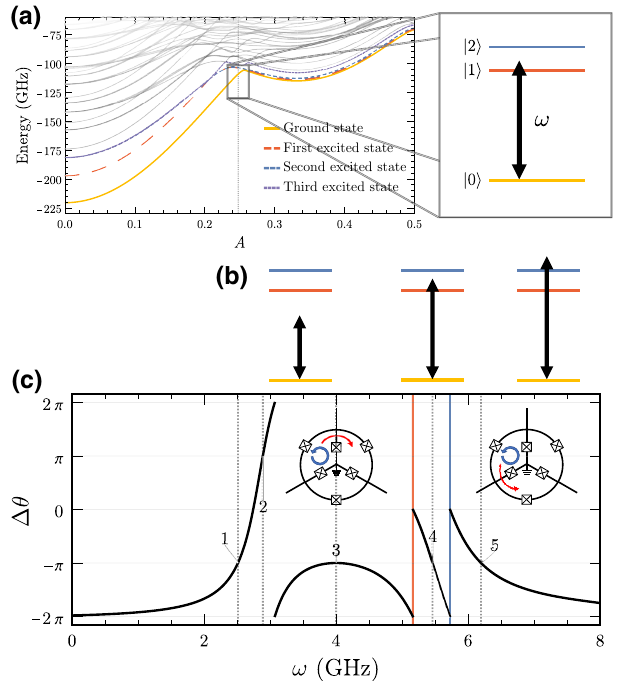
FIG. 4. (a),(b) The energy-level structure at our chosen oper- ating point A ≈ 0.2478 and the available transitions from the ground state. (c) The phase difference (cid:20)θ as a function of driv- ing frequency ω , with insets that indicate the predominant vortex dynamics. Dashed vertical lines indicate the target frequencies at which (cid:20)θ = ± π , ± 3 π . . . , the values that satisfy the condi- tions for nonreciprocity. These points are enumerated for future reference. The red and blue vertical lines indicate the first and second excited energies, respectively, for the central circuit. The parameters chosen for this plot are E J / h = 4 E C / h ≈ 45 GHz, , E J / E (cid:3) ≈ 40, C C = 6 C J , C G = 0.02 C J , and where E C = e 2 2 C J A ≈ 0.2478. Offset charge is tuned such that the total Cooper pair number in the ground state is approximately 1.2, with N g 1 = N g 2 = N g 3 ≈ 0.4.